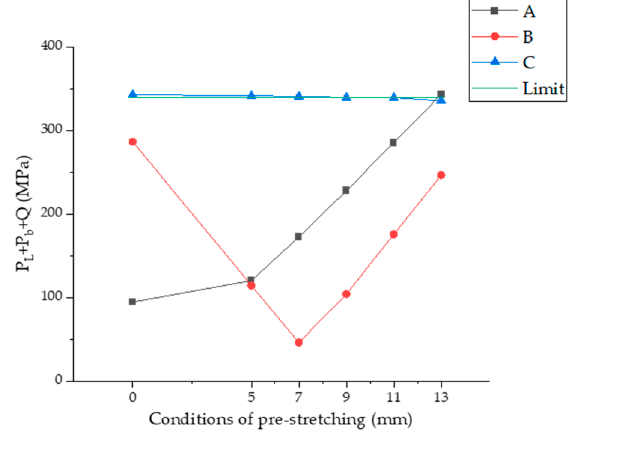
Figure 10. P L assessment at positions A, B and C under load case 1 with varying pretensions.